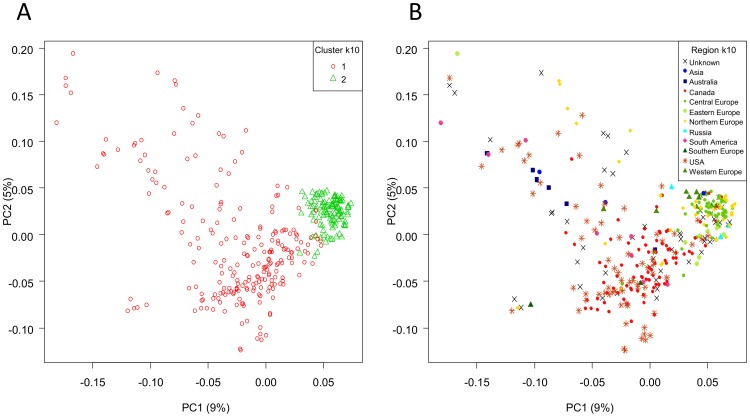
Scatter plots of PC1 vs. PC2.The k10 correction is shown: (A) coloured based on clustering from genotypic data, (B) coloured based on geographic origins.